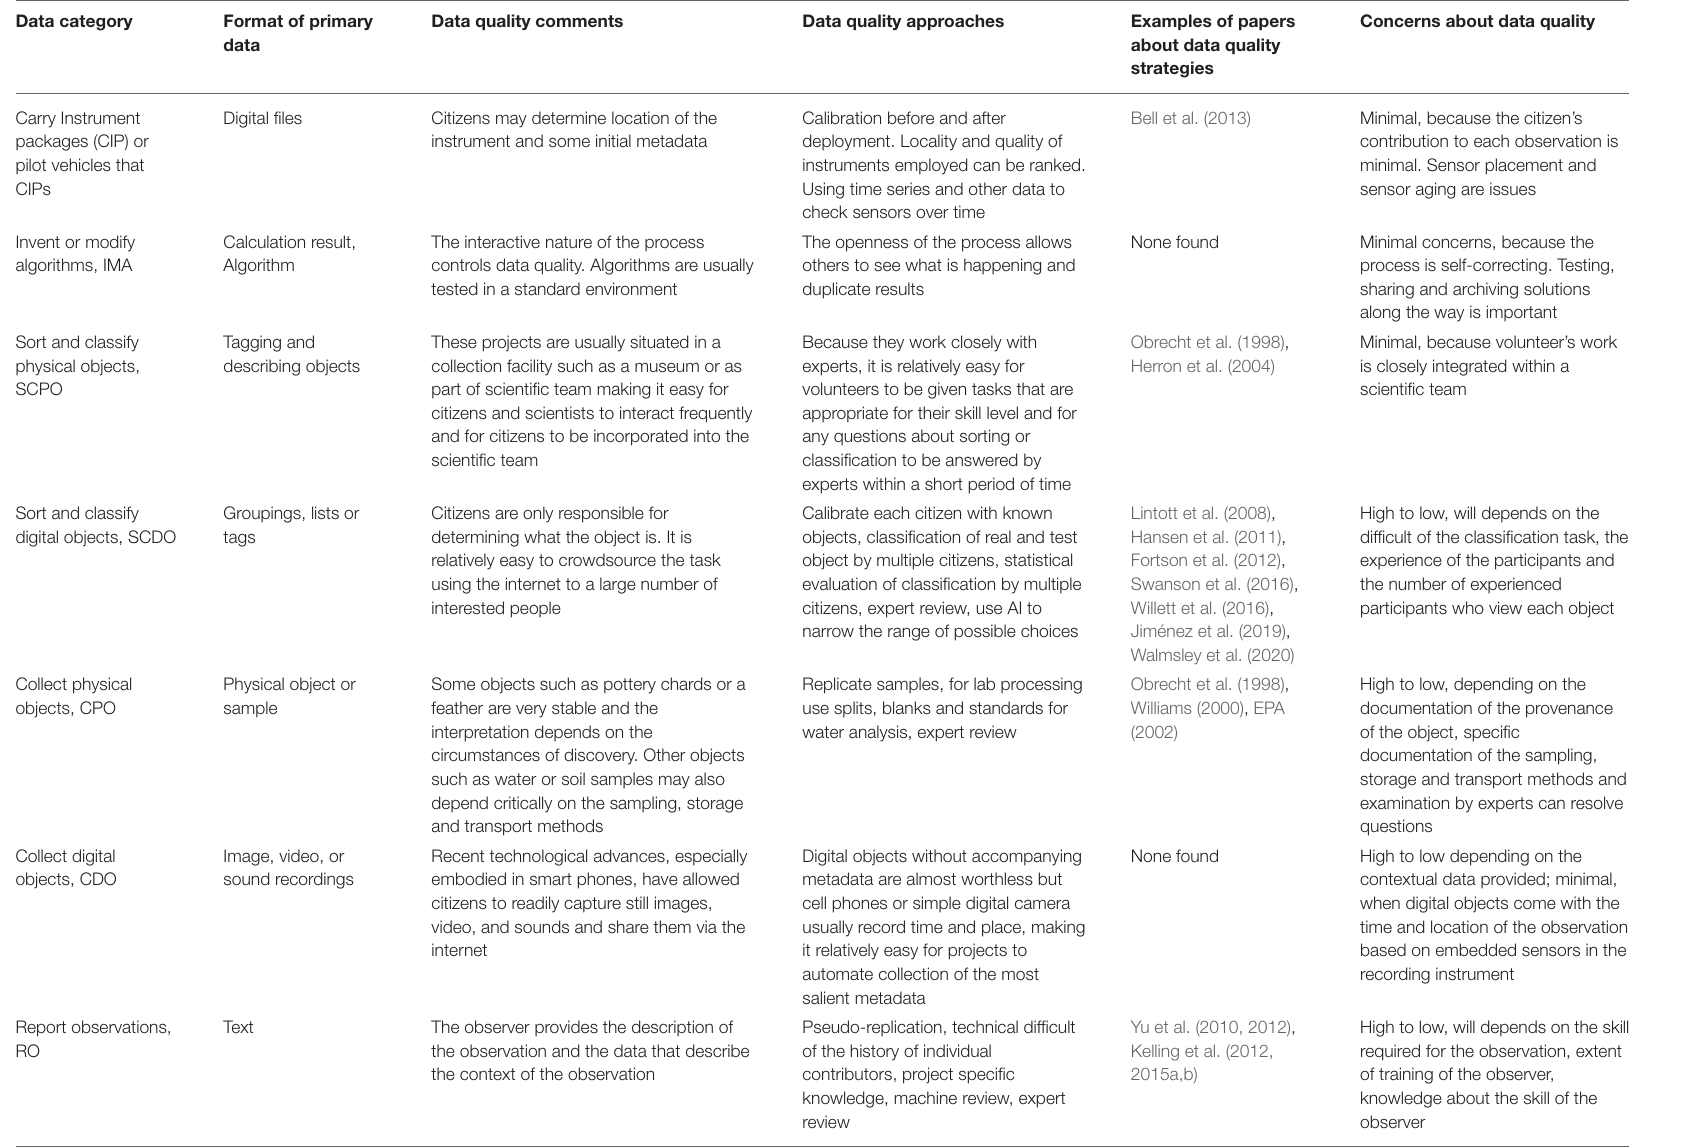
TABLE 2 | Characteristics of seven data types related to data